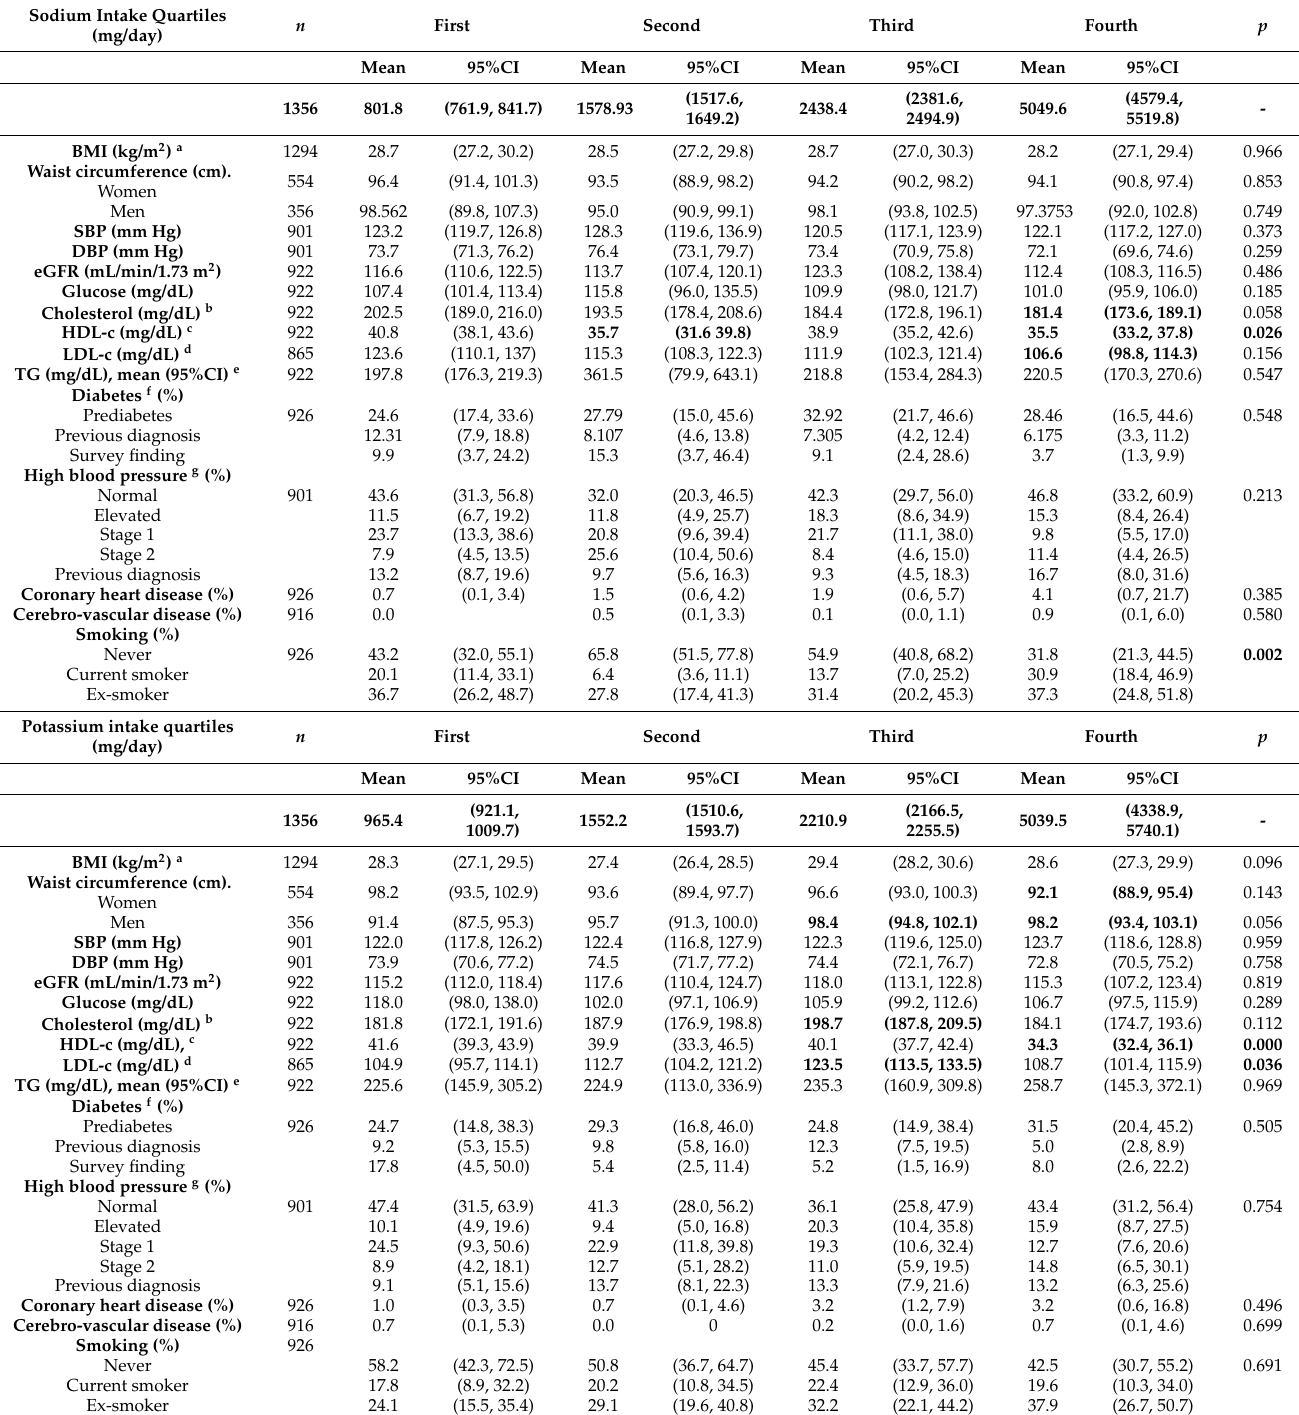
Table 4. Nutrition status and clinical characteristics according to quartiles of sodium and potassium intake in adults: